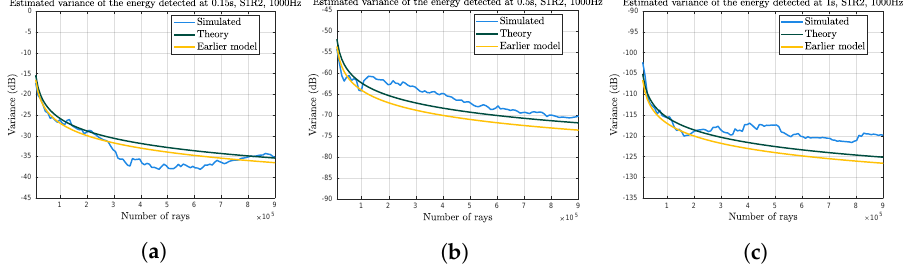
Figure 6. Graphs illustrating how the estimated and modelled variance in a given time frame changes as the number of rays used changes, at 0.15 s ( a ), 0.5 s ( b ) and 1 s ( c ). The two th eoretical estimates decrease as the number of rays increase and seem to do so at a similar or equal rate. While the results from simulations are more noisy, they seem to follow a similar pattern and are quite close to both theoretical